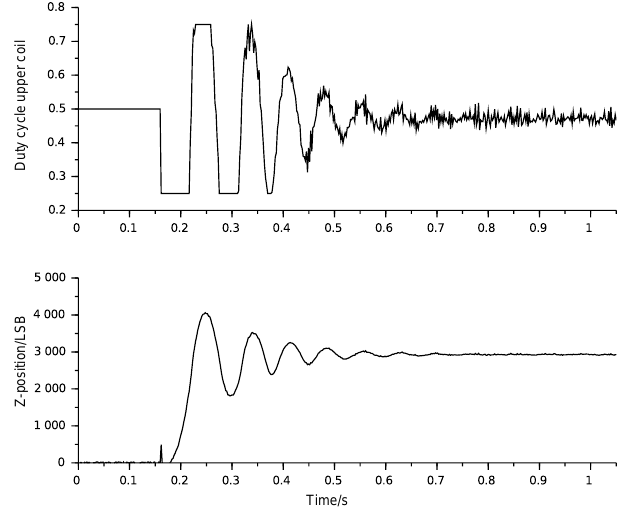
Figure 9. Settling of the vertical controller; top: duty cycle for the upper actuator coil (0.5 = neutral); bottom: vertical position of the ball.